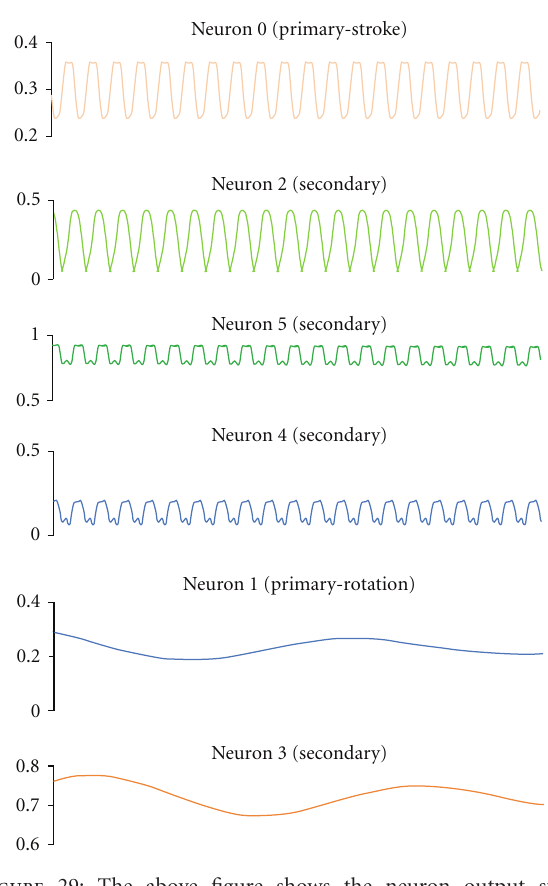
Figure 29: The above figure shows the neuron output state dynamics of each neuron in the low frequency group (1 and 3) and high frequency group (0, 2, 4, and 5) after intergroup amputation is performed and evaluated in absence of the external altitude sensor signal (represented in Figure 28). It can be noticed that each qualita- tive group is self-su ffi cient to generate internal dynamics to sustain steady oscillations independent of the external sensor signal. But, nonetheless low frequency group neurons seem to be susceptible to external sensor signal due to their high time constants.